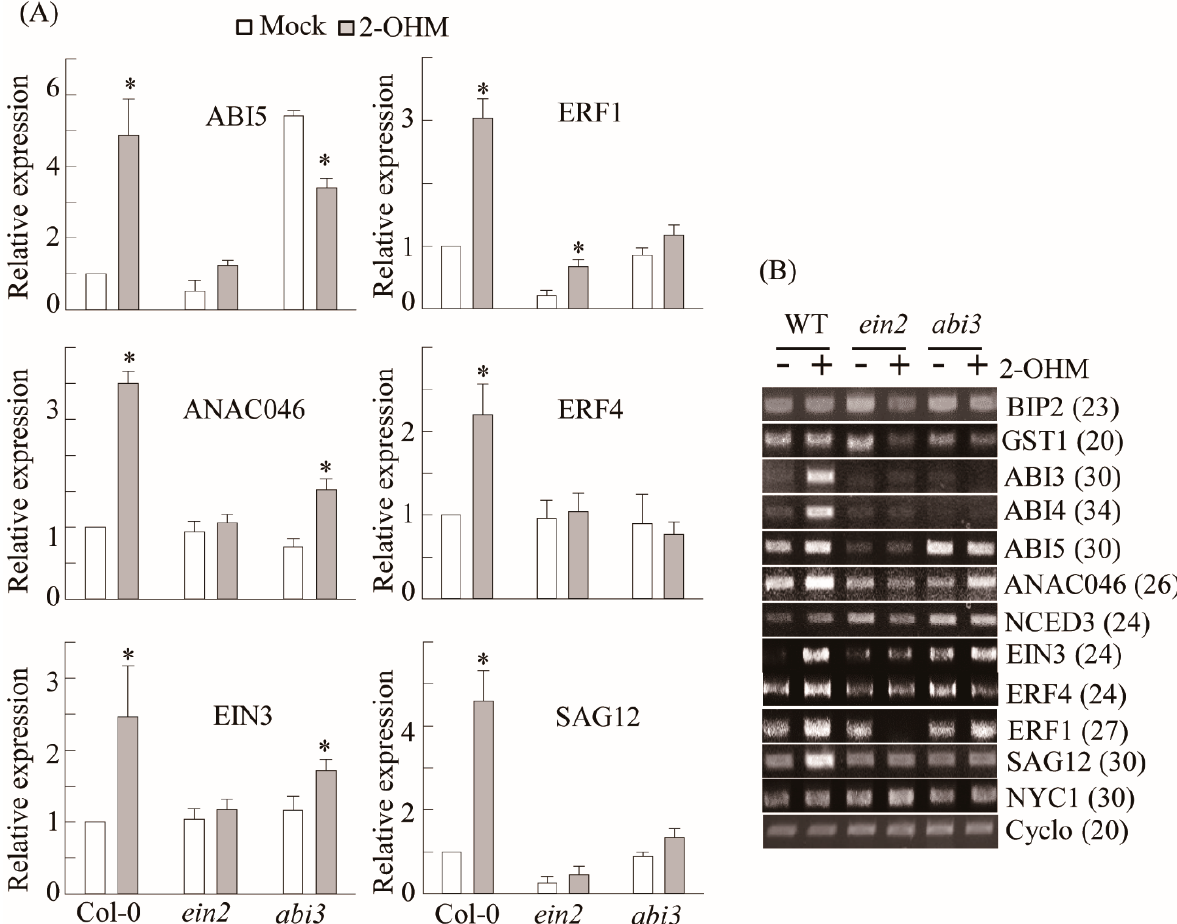
Figure 5. EIN2- and ABI3-dependent gene induction in response to 2-OHM treatment. ( A ) qRT-PCR analysis results. ( B ) RT-PCR analysis results. Arabidopsis WT (Col-0), ein2 , and abi3 plants were treated with 2-OHM (1 μ M). Leaves were infiltrated with solutions and incubated under dim light conditions for 2 h prior to sample harvesting. Mock treatment consisted of 5 mM MgCl 2 in 2 mM MES (pH 5.6). Cyclo was used for qRT-PCR normalization and as a loading control for RT-PCR. GenBank accession numbers were as follows: ABI3 (AT3g24650), ABI4 (AT2g40220), NCED3 (AT3g14440), EIN3 (AT3g20770), and NYC1 (AT4g13250). Other genes are listed in Figure 4. Asterisks (*) indicate significant differences from the mock control, determined using Tukey’s post-hoc HSD test at a level of p < 0.05. Numbers in parentheses indicate the number of PCR cycles.